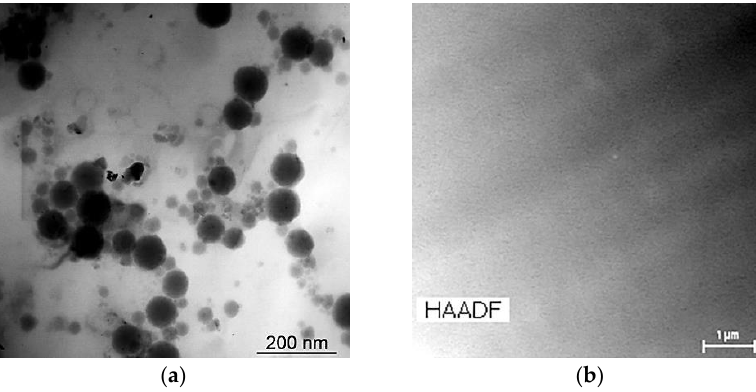
Figure 12. Progress in homogeneity from: ( a ) oxide-based; to ( b ) sol-gel-based granulated silica method [7].